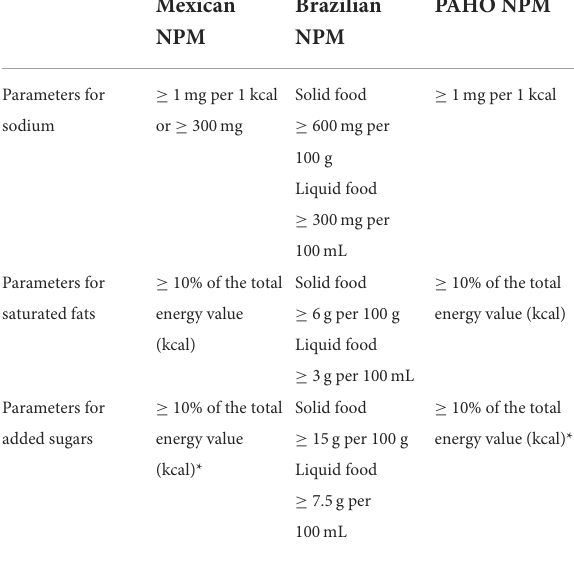
TABLE 2 Differences between the three nutritional profile models (NPM) used in assessing understanding of the critical nutritional content of the